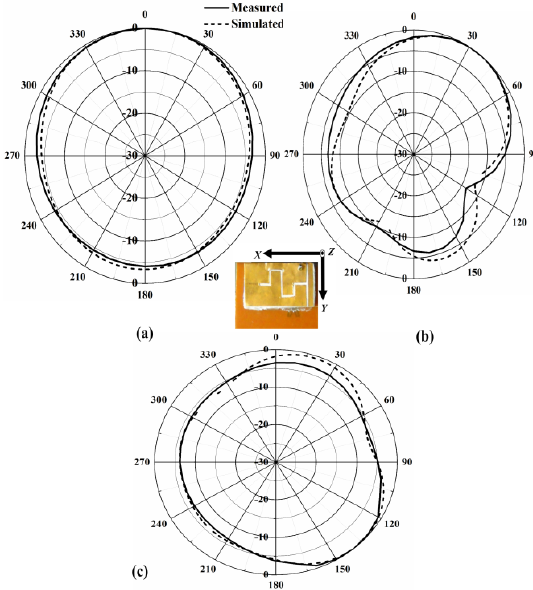
Figure 10: Measured and simulated 2-D principal plane pattern of the proposed antenna at 1.8 GHz (a) x-z plane (b) y-z plane (c) x-y